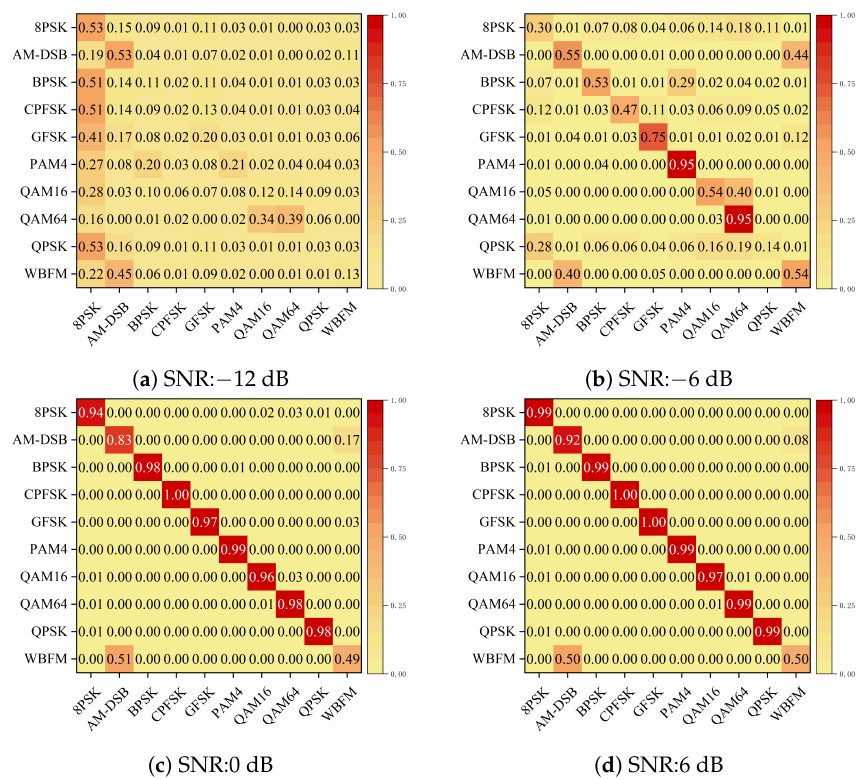
Figure 12. Confusion matrix for TMRN-GLU. The ( i , j ) denotes the probability of being classified as a test instance of the modulation type. ( a ) is under − 12 dB SNR; ( b ) is under − 6 dB SNR; ( c ) is under 0 dB SNR; ( d ) is under 6 dB.